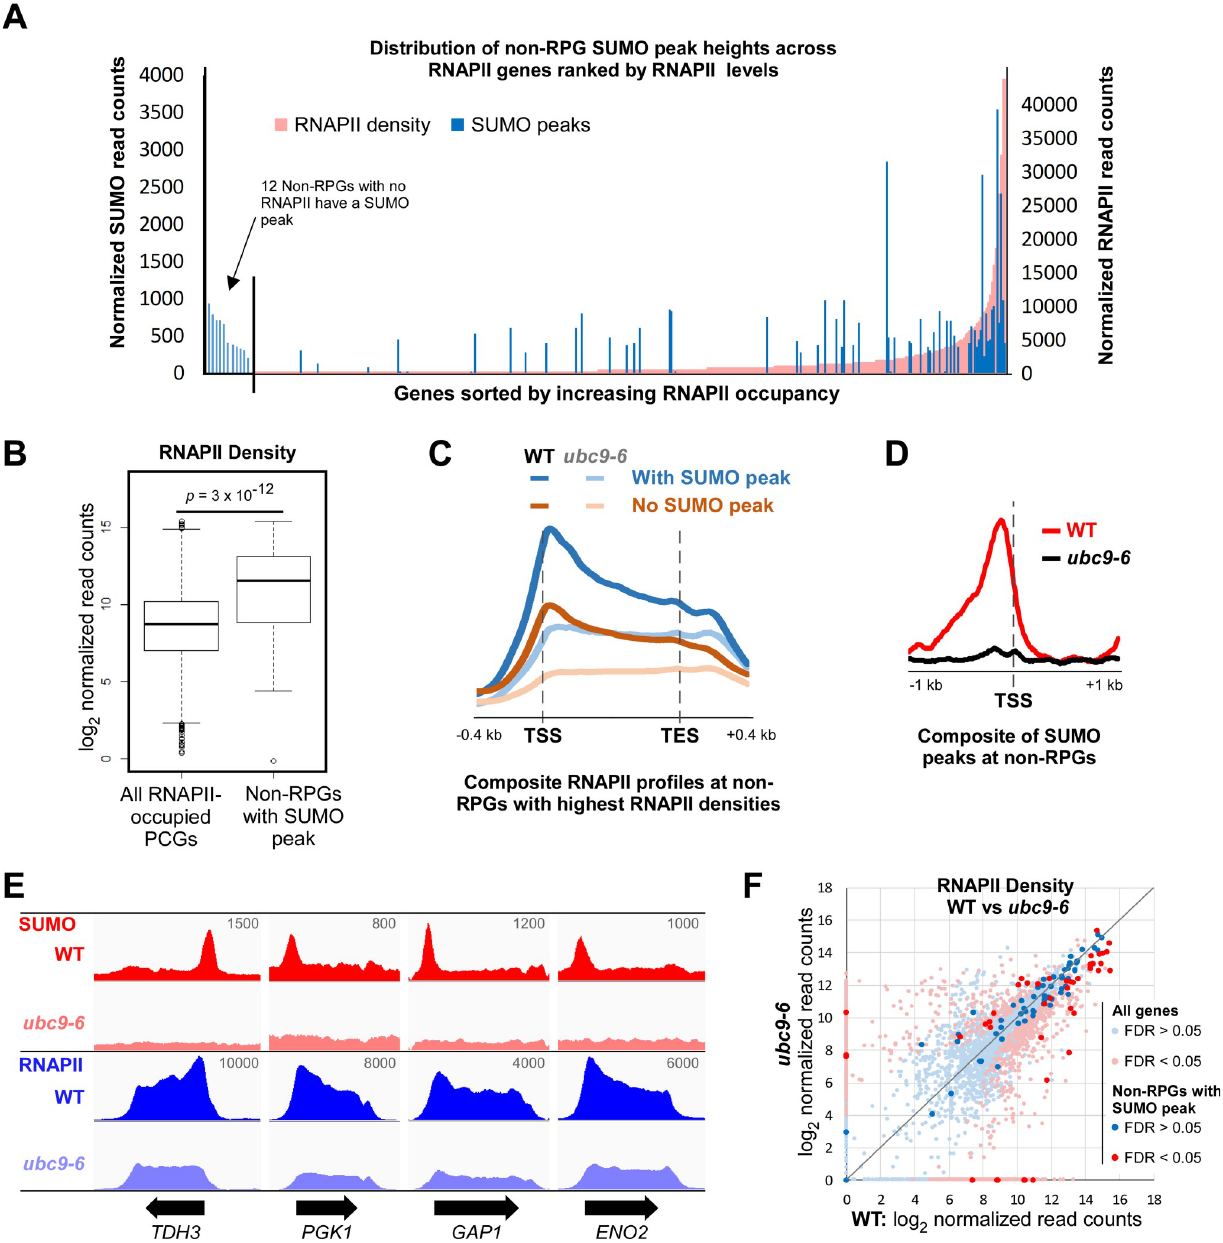
Fig 2. Many highly transcribed non-RPGs have a promoter-associated SUMO peak. (A) Comparison of SUMO peak-containing genes by transcription level. The 111 SUMO peaks (blue) associated with single non-RPGs were plotted, by normalized read count, over the ranked distribution of RNAPII densities (pink) of all protein-coding genes (PCGs), which are approximations of transcription levels and were determined by duplicate independent RNAPII ChIP-seq analyses performed in the same strain and conditions as the SUMO ChIP-seq. Inset shows 12 SUMO peaks of the set of 111 that are associated with genes that have no detected RNAPII density. See S11 Table for list of RNAPII densities by gene. (B) Box plot comparing RNAPII densities for all RNAPII-occupied genes and for the 111 non-RPGs with unique SUMO peaks. P -value of Student’s t -test analysis is shown. (C) Composite plots of RNAPII ChIP-seq profiles in WT or ubc9-6 cells at non-RPGs with the highest RNAPII densities (top 10%) that either contain or lack promoter-associated SUMO peaks, as indicated. Plots were generated using the ComputeMatrix tool (from deepTools 3.3.0). TSS , transcription start site; TES , transcription end site. (D) Composite plots of SUMO peaks associated with single non-RPGs in WT or ubc9-6 cells, shown relative to nearest TSS, generated using ComputeMatrix. (E) Unnormalized ChIP-seq peak alignments for SUMO and RNAPII in WT and ubc9-6 cells at four selected genes with normally high RNAPII densities (i.e. in WT cells). Values refer to maximum data range (read numbers) for the view shown per gene for both WT and corresponding ubc9-6 alignments. (F) Plot of RNAPII densities of all protein-coding genes in WT versus ubc9-6 cells, with densities at the 111 non-RPGs associated with unique SUMO peaks highlighted. See S11 Table for list of RNAPII densities in WT and ubc9-6 strains by gene.